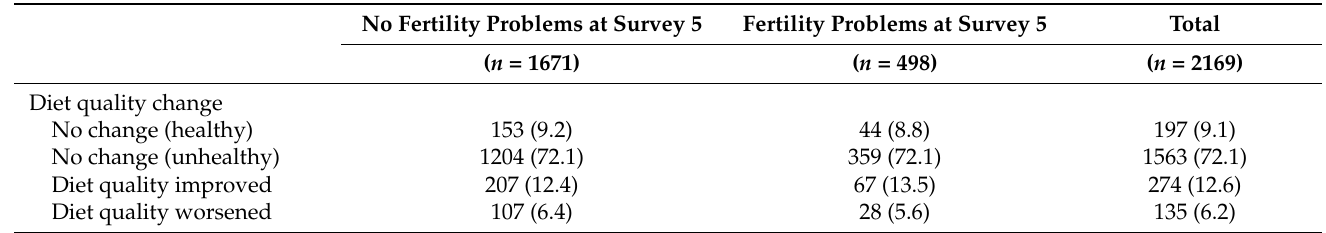
Table 4. Diet quality change (from Survey 3 to Survey 5) by fertility problem status in Survey 5.